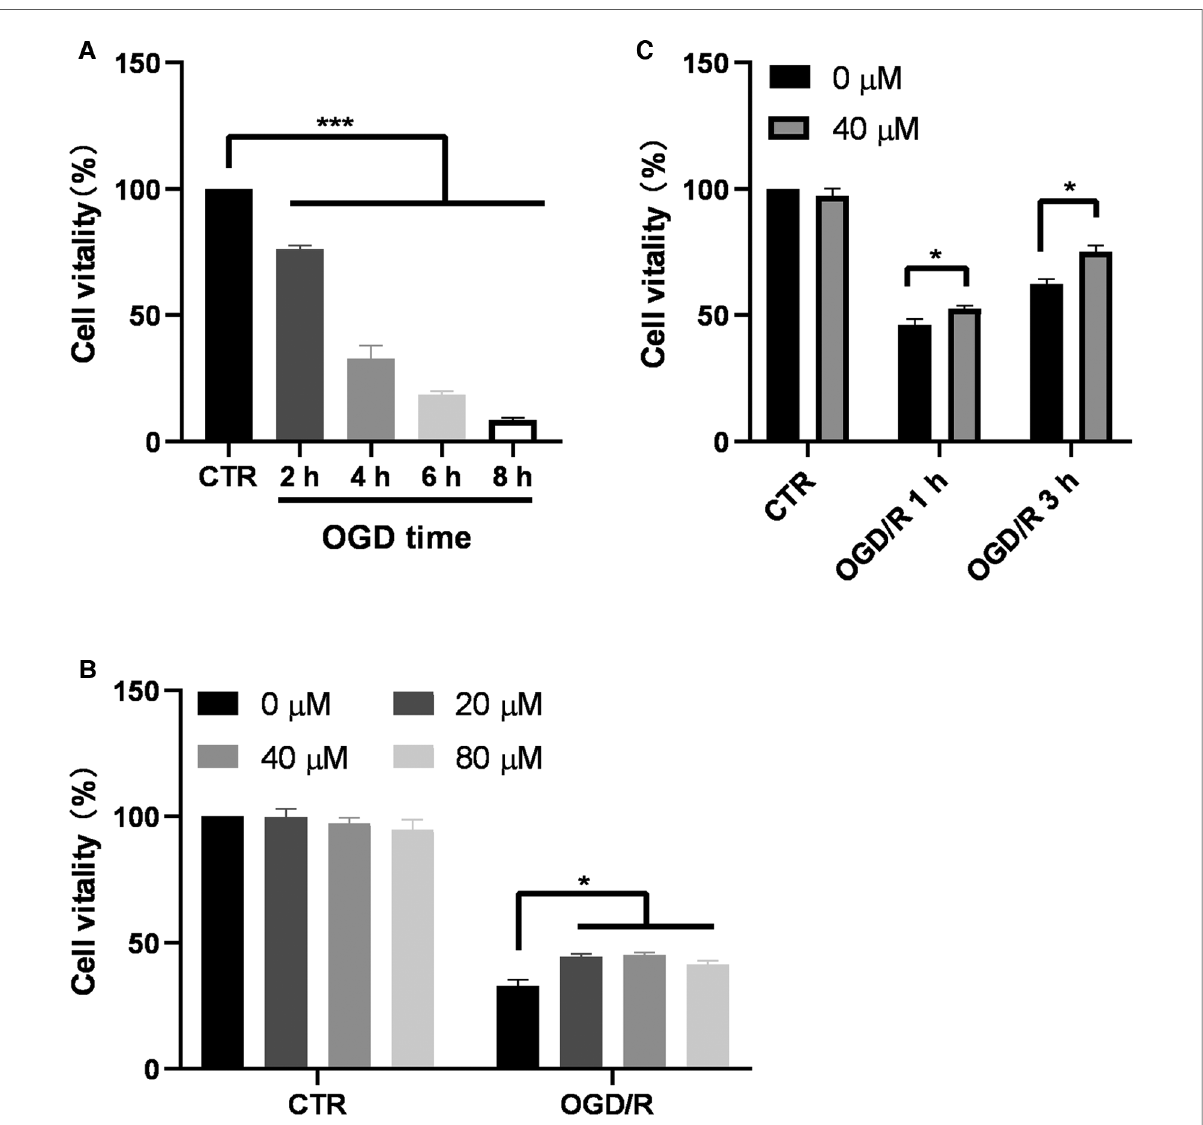
FIGURE 2 Ga increases BV2 cell viability after OGD/R. (A) BV2 cells were exposed to OGD for 2, 4, 6 and 8 h and the cell viability was detected by CCK-8 assay ( n =6). (B ) Effect of different GA concentrations on cell viability of control cells for 7 h (CTR) and the cells treated with OGD for 4 h followed